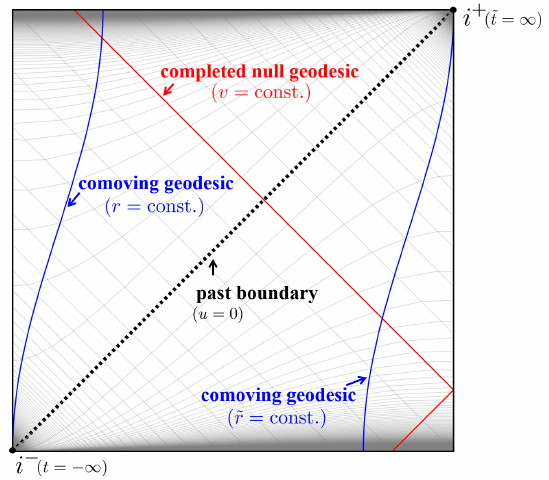
Figure 2 . Penrose diagram of past completed universe: the region above the boundary (dashed line) represents an expanding universe and that below the boundary represents a contracting universe. The comoving geodesics in the expanding universe ( r = constant) does not enter the contracting region, contrary to the standard bouncing universe where comoving observers pass through both the expanding and contracting epoch. The null geodesic ( v = constant) pass through the boundary of the original inflationary universe, where it could be a parallelly propagated curvature singularity depending on the